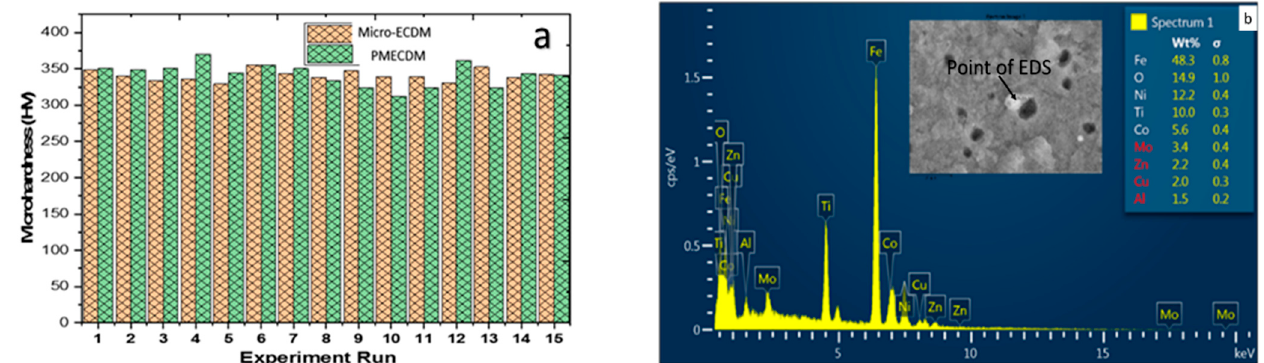
Figure 8. ( a ) Microhardness profile ( b ) point EDS of debris particle in